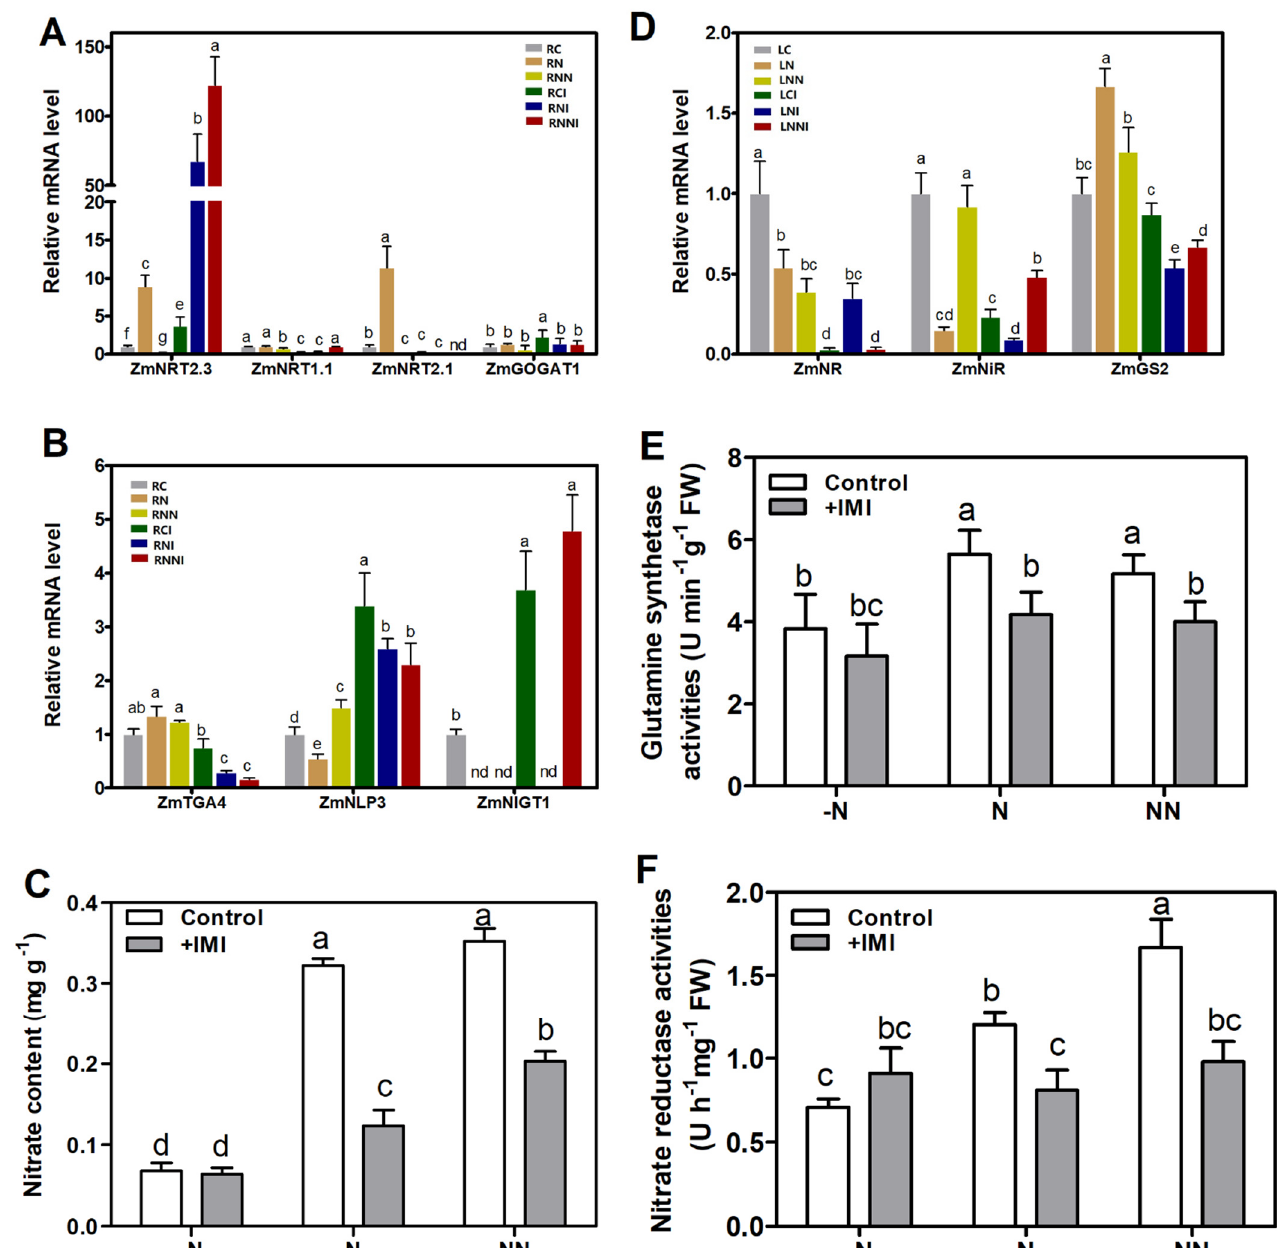
Figure 7. Imidacloprid affects nitrogen absorption and metabolism in maize. The relative mRNA levels of several genes related to nitrogen absorption and metabolism under 5 ppm IMI treatment, for 24 h, in roots ( A , B ), or for 48 h in shoots ( D ). Steady-state mRNA levels in roots were normalized against Zmactin1 gene and were expressed relative to those of the control plants, which were given a value of 1 (not shown). The content of nitrates in maize seedlings ( C ). The activity of NR and GS in shoots ( E , F ). Bar values are means ± SD of three biological replicates, each corresponding to dif- ferent RNA extractions from tissues of three plants independently grown. Lower case letters indi- cate significant differences among treatments.